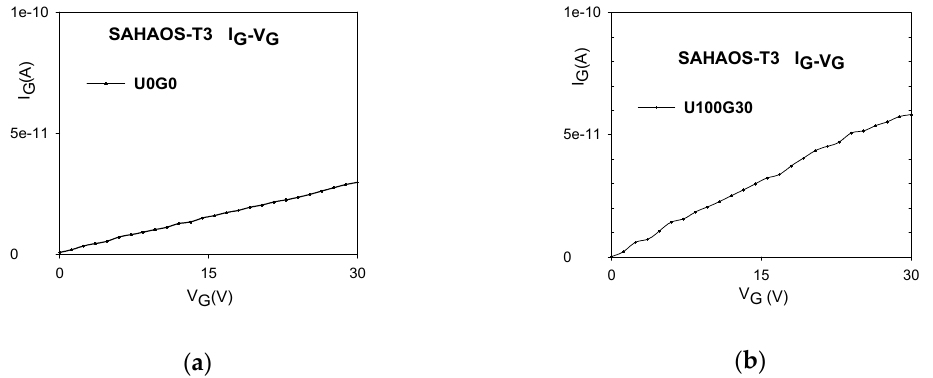
Figure 7. The gate leakage current at PGV 30 V for an SAHAOS-T3 capacitor device ( a ) before UV irradiation; ( b ) after U100G30 irradiation.